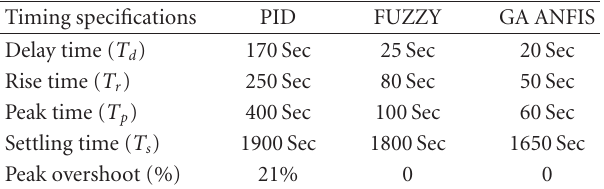
Table 6: Timing specification of PID, FLC, and GA ANFIS